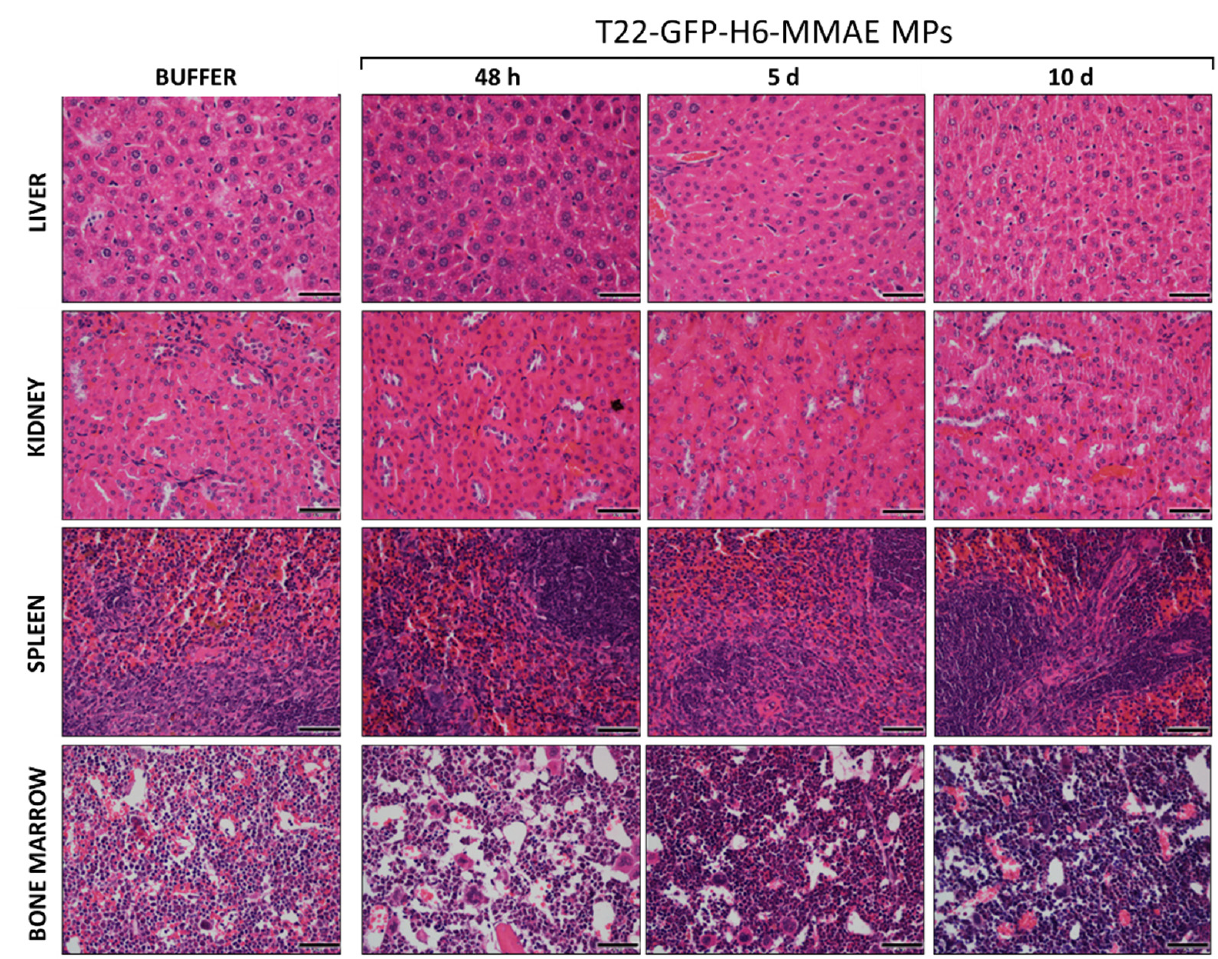
Figure 3. Toxicity analysis of T22-GFP-H6-MMAE MPs in a SC CXCR4 + DLBCL mouse model. H&E staining of the liver, kidney, spleen and bone marrow of mice treated with buffer or MPs at 48 h, 5 and 10 days after the treatment. Pictures were taken at 400× (scale bars = 50 μ m).